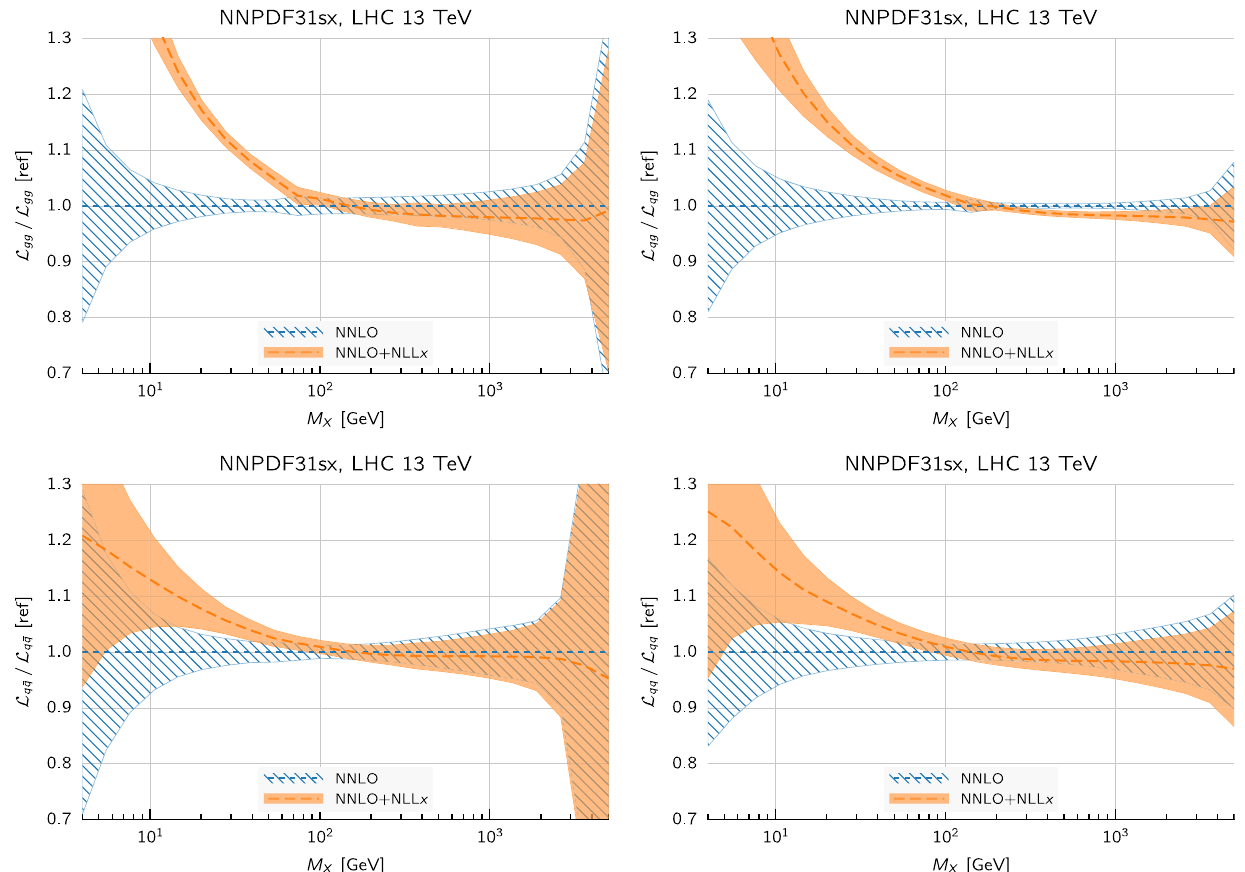
√ s = 13 TeV as a function of the